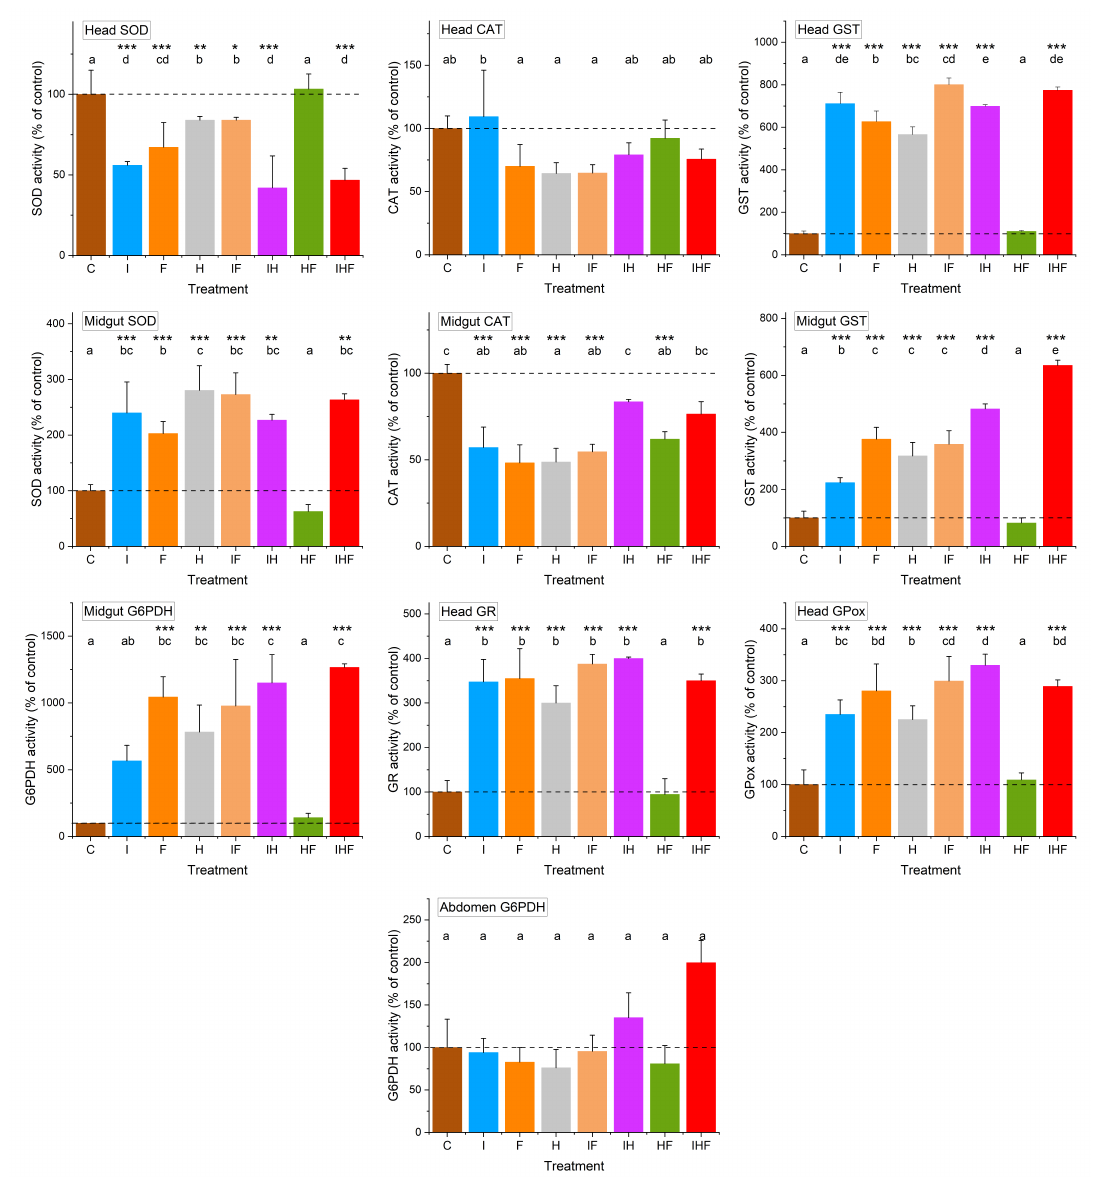
Figure 3. Effects of exposure to pesticides at 1 µ g/L on antioxidant defenses. Winter honey bees were orally exposed to food containing no pesticides (C), imidacloprid (I), difenoconazole (F), glyphosate